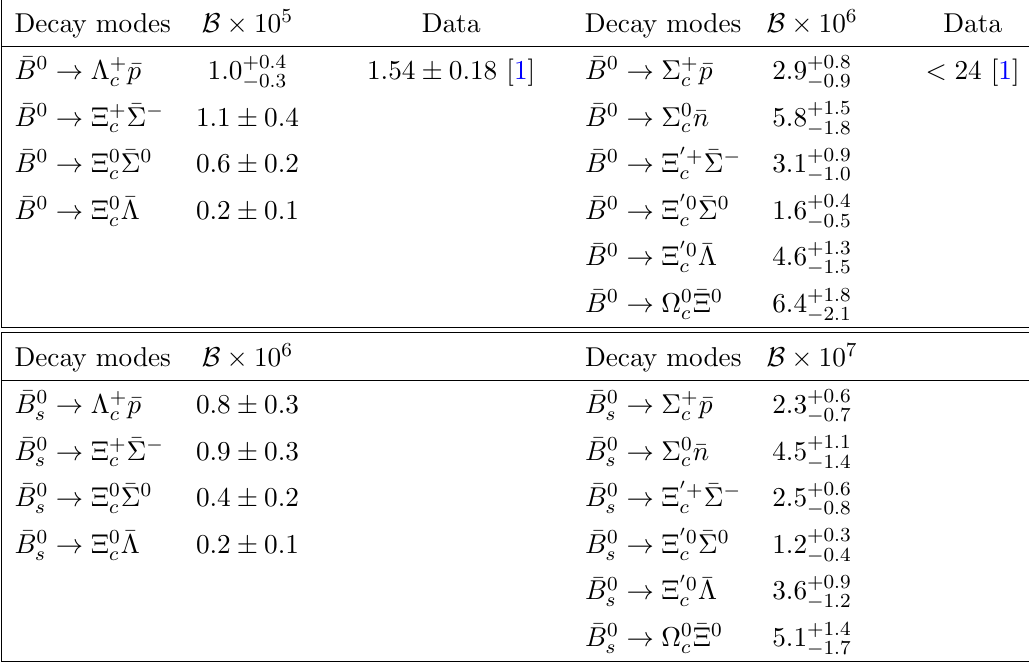
B c (cid:22) B 0 decays from the W -exchange diagrams. ( s ) !